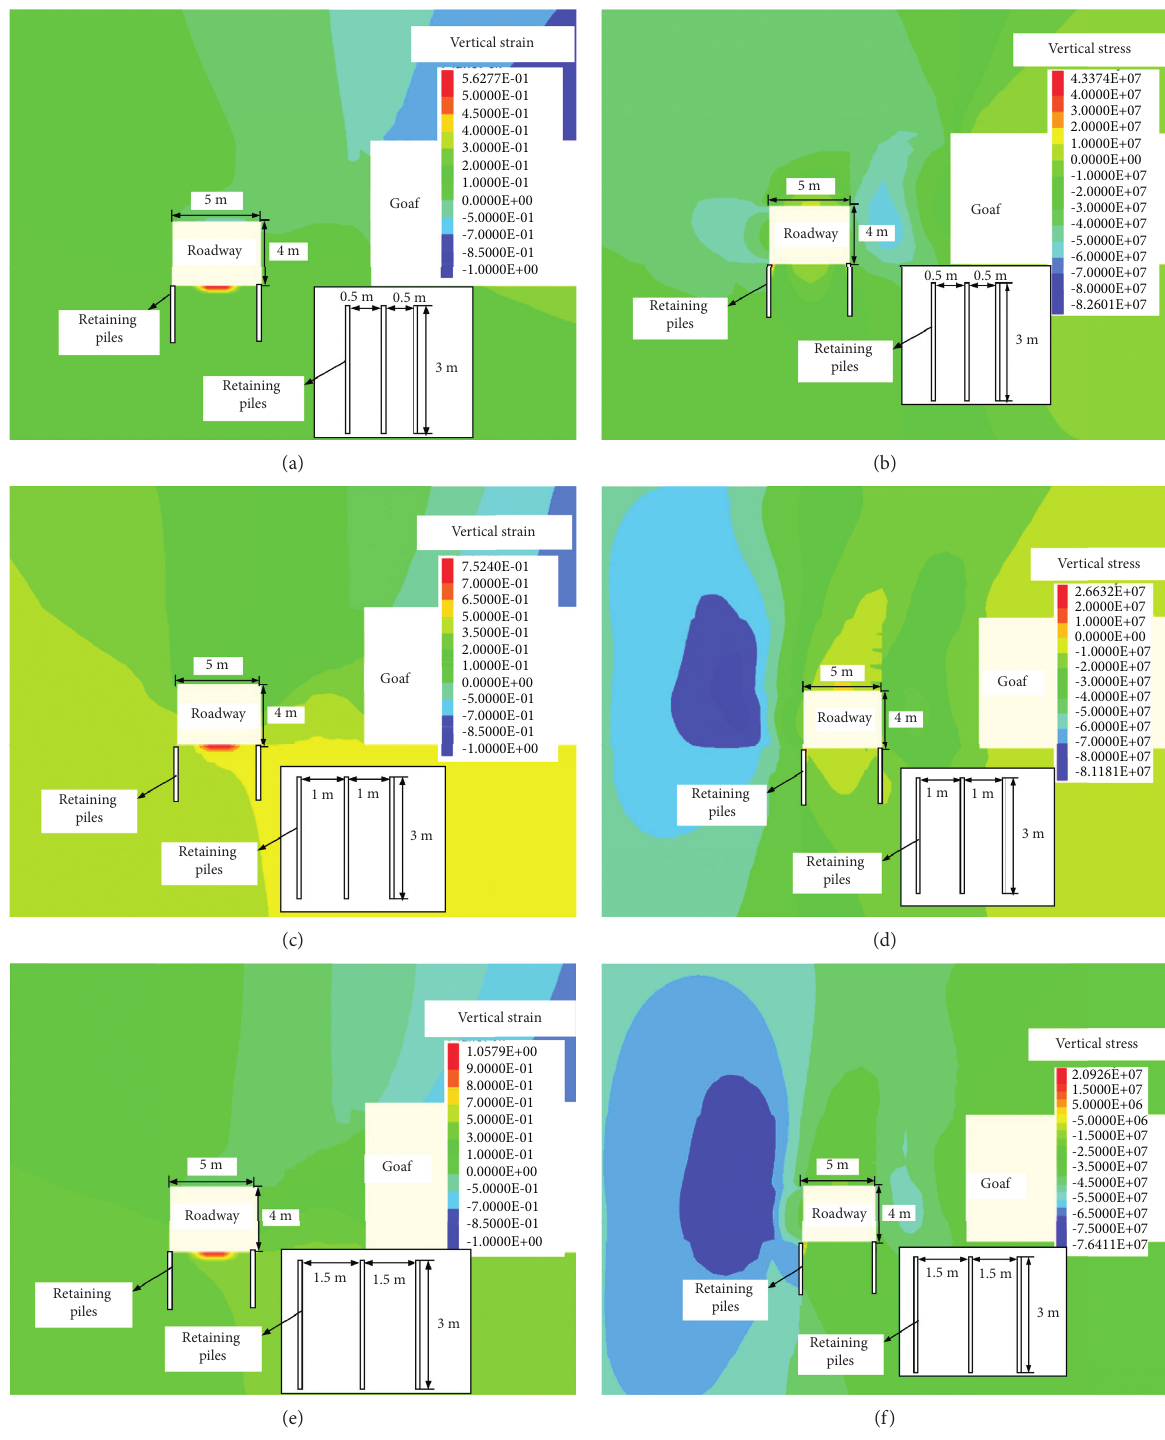
Figure 8: Deformation and stress distribution of roadway surrounding rocks with different spacings of retaining piles. (a) Vertical strain of 0.5m; (b) vertical stress of 0.5 m; (c) vertical strain of 1.0 m; (d) vertical stress of 1.0m; (e) vertical strain of 1.5m; (f) vertical stress of